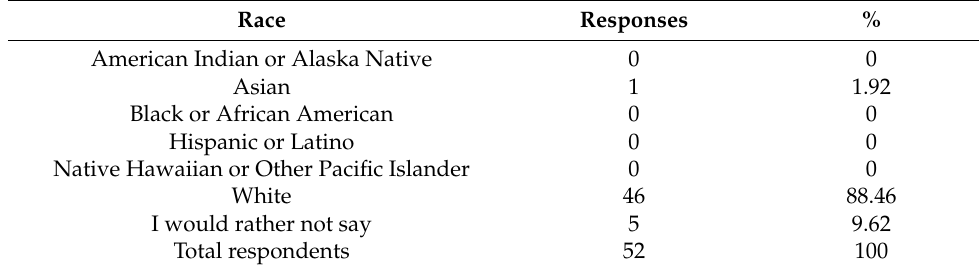
Table A1. Race distribution of survey respondents.